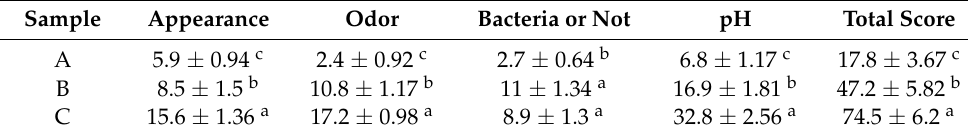
Table 6. The results of the sensory evaluation of fermentation